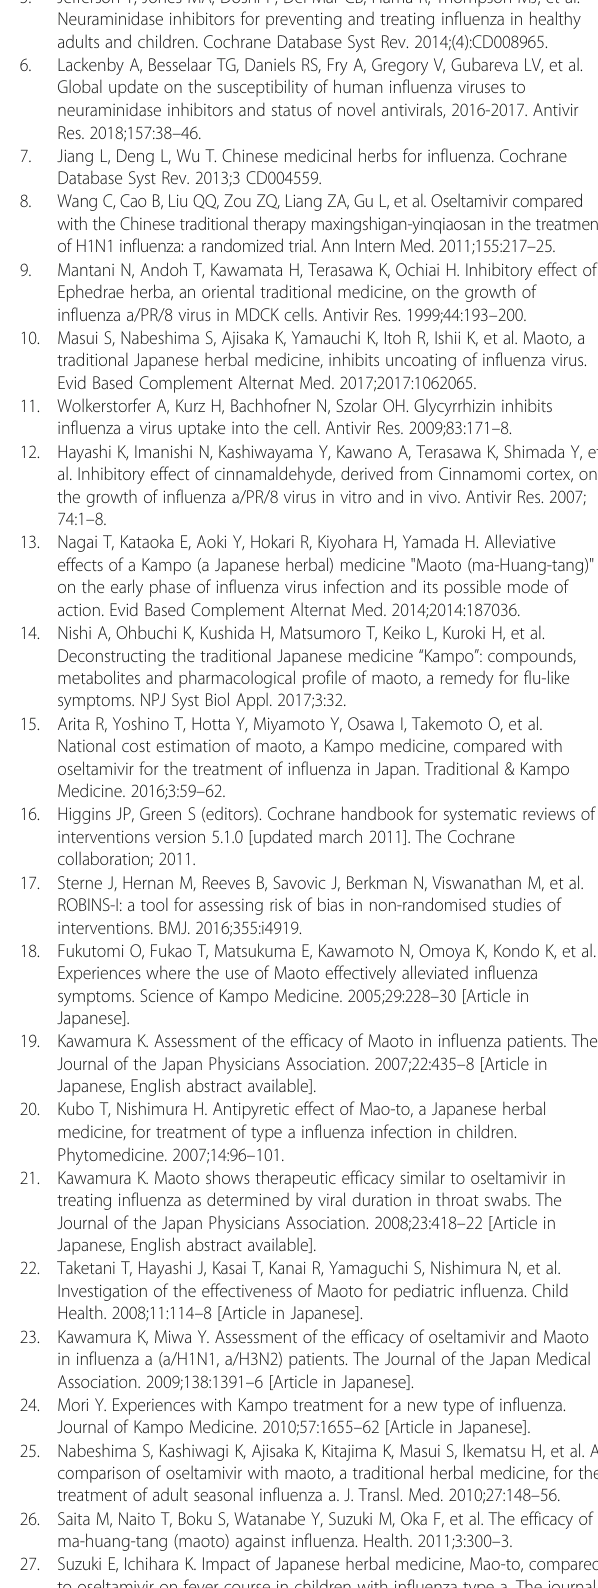
Additional file 4: Figure S2. Funnel plot of overall symptom duration after drug administration: maoto vs. neuraminidase inhibitors. SE, size of effect; MD, mean difference. (PDF 38 kb) Additional file 5: Figure S3. Funnel plot of fever duration after drug administration: maoto vs. neuraminidase inhibitors. SE, size of effect; MD, mean difference. (PDF 74